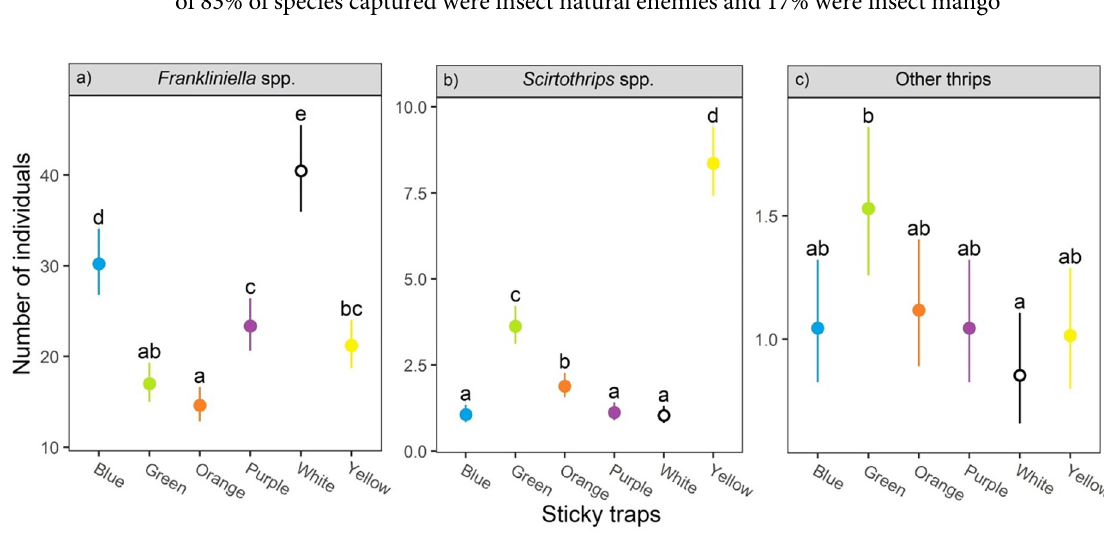
sampling date showed no significant differences in the catch rates of either natural enemies ( χ 2 = 20; df = 35; P = 0.98) or insect pollinators ( χ 2 = 17.9; df = 35; P = 0.99). Sticky traps captured 5,136 beneficial arthropods throughout the sampling period. A total of 83% of species captured were insect natural enemies and 17% were insect mango